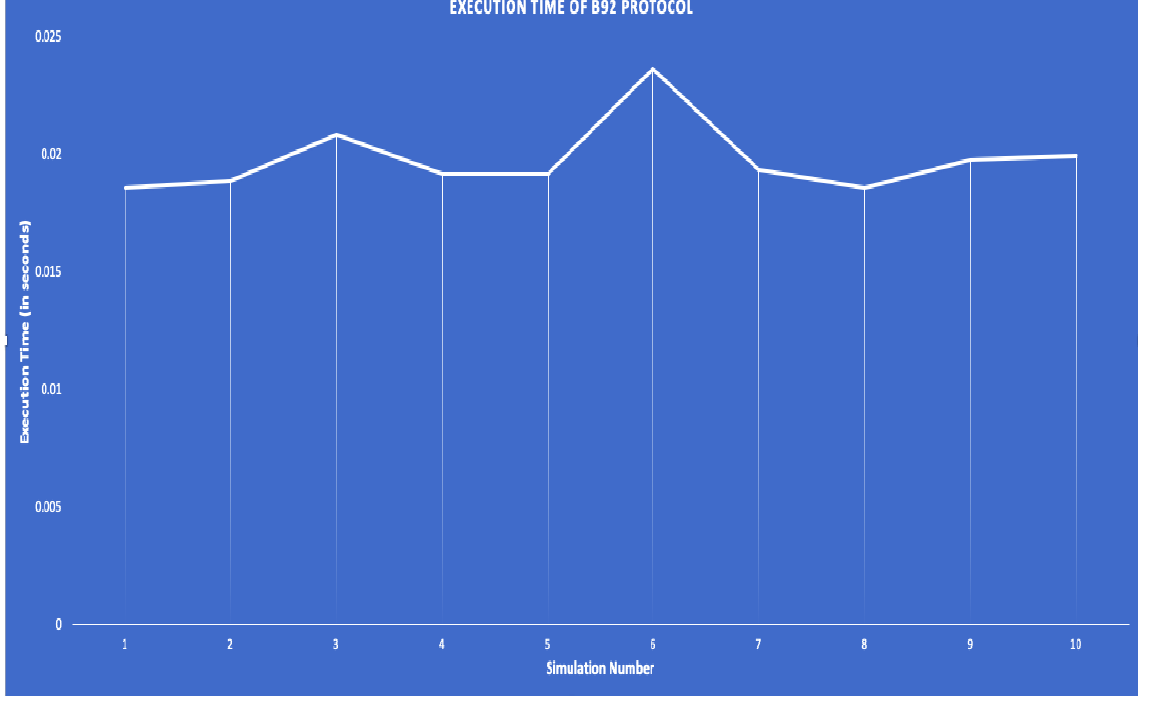
Figure 14. Execution Time of B92 protocol.